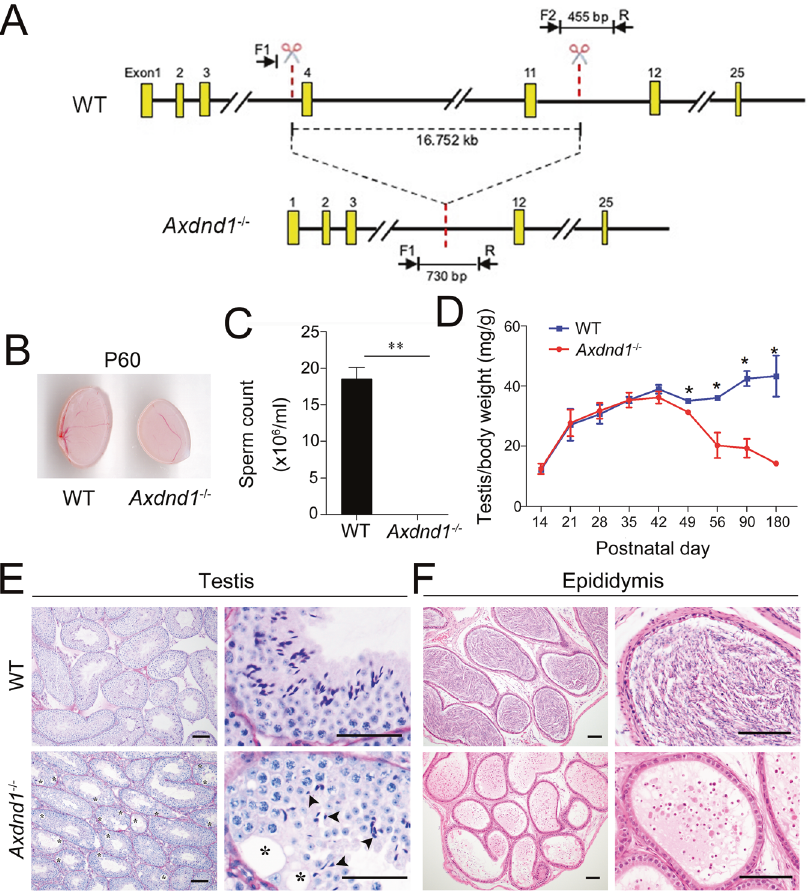
Fig. 3 Axdnd1 − / − male mice are infertile with small testis size and abnormal spermiogenesis. A The strategy used to generate Axdnd1 knockout mouse model via CRISP/Cas9 technology. A large fragment (16.752 kb) was deleted in Axdnd1 − / − mice. B Gross morphology of testes from wild type (WT) and Axdnd1 − / − male mice at postnatal day 60 (P60). C Sperm counts analysis in caudal epididymis. Mature sperm was hardly found in the caudal epididymis of Axdnd1 − / − mice. Data are presented as Mean ± SEM, n = 6. ** P < 0.01 by Student ’ s t -test. D Testis growth curve (ratio of the testis to body weight) in WT and Axdnd1 − / − mice. The testis of Axdnd1 − / − mice began to be smaller than WT at P49. Data are presented as Mean ± SEM, n = 3. * P < 0.05. E – F Histological analysis of the testis ( E ) and caudal epididymis ( F ) from WT and Axdnd1 − / − mice. Vacuoles (labeled by asterisks) and ill-shaped nuclei (labeled by black arrowheads) were observed in the seminiferous tubules of Axdnd1 − / − mice. Scale bar: 100 µm.